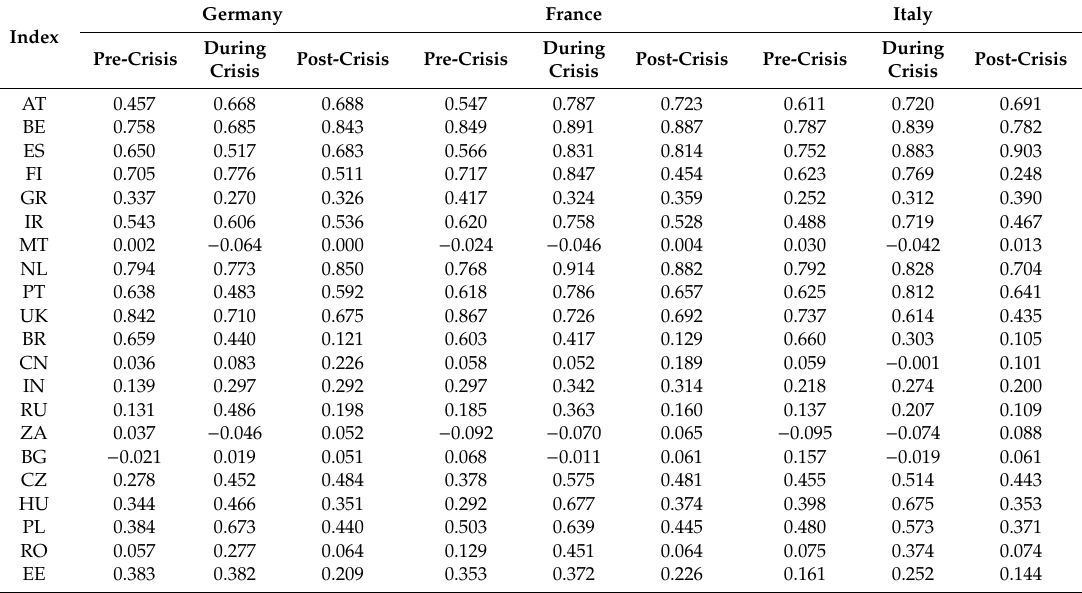
Table A4. Cross correlations coe ffi cients between lag residual series during Pre-EZC. EZC and